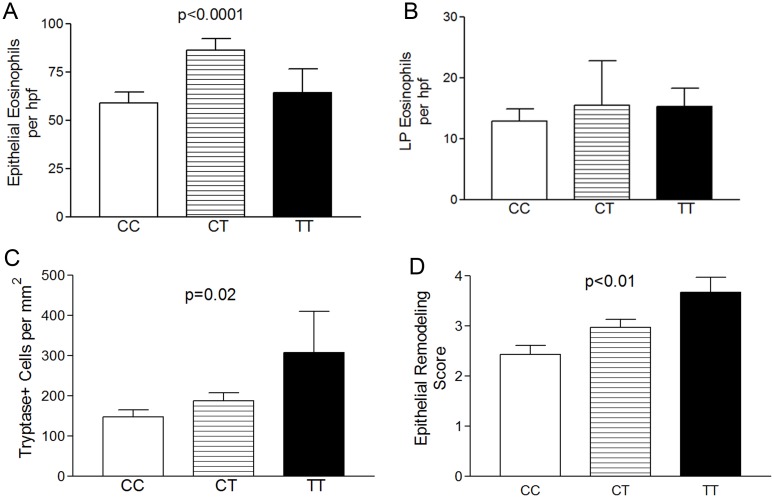
Inflammatory cells and epithelial remodeling by genotype.CT genotype subjects have the highest numbers of epithelial (A) and lamina propria (LP) eosinophils (B) but TT genotype subjects have the highest numbers of tryptase positive mast cells (C) and epithelial remodeling (D). Bars represent mean with standard error.